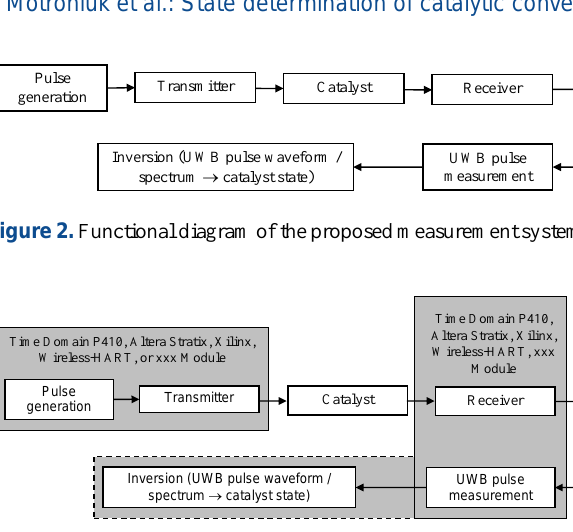
Figure 3. Exemplary hardware implementation of the proposed measurement system.